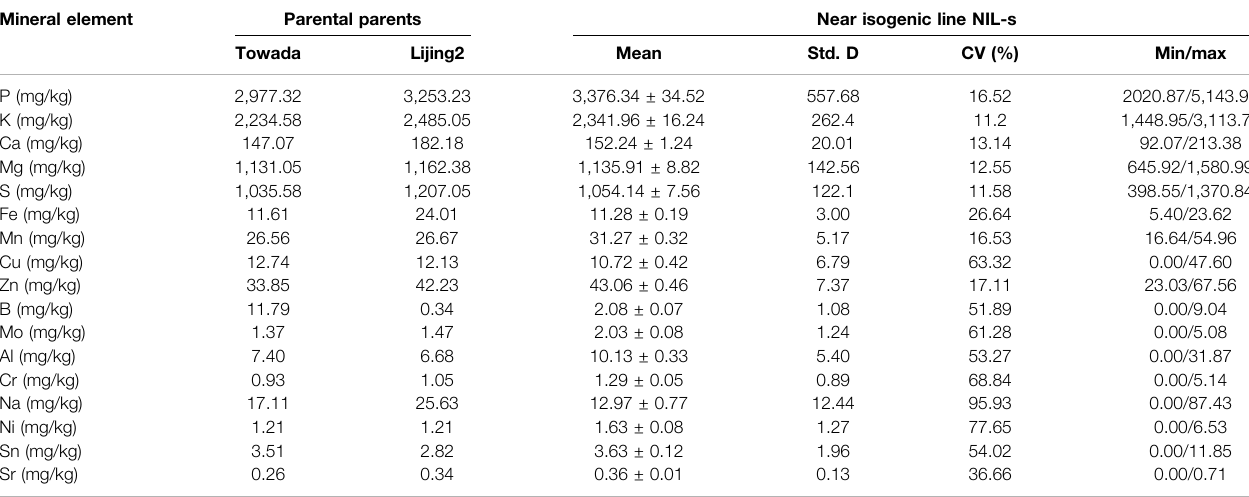
TABLE 1 | The mean, SD, coef fi cient of variation and ratio between maximum and minimum content of 17 mineral elements in the parent (Towada and Lijiang2) and in the population of near-isogenic lines (NILs) of Towada brown rice subjected to cold stress at booting stage. Mineral element Parental